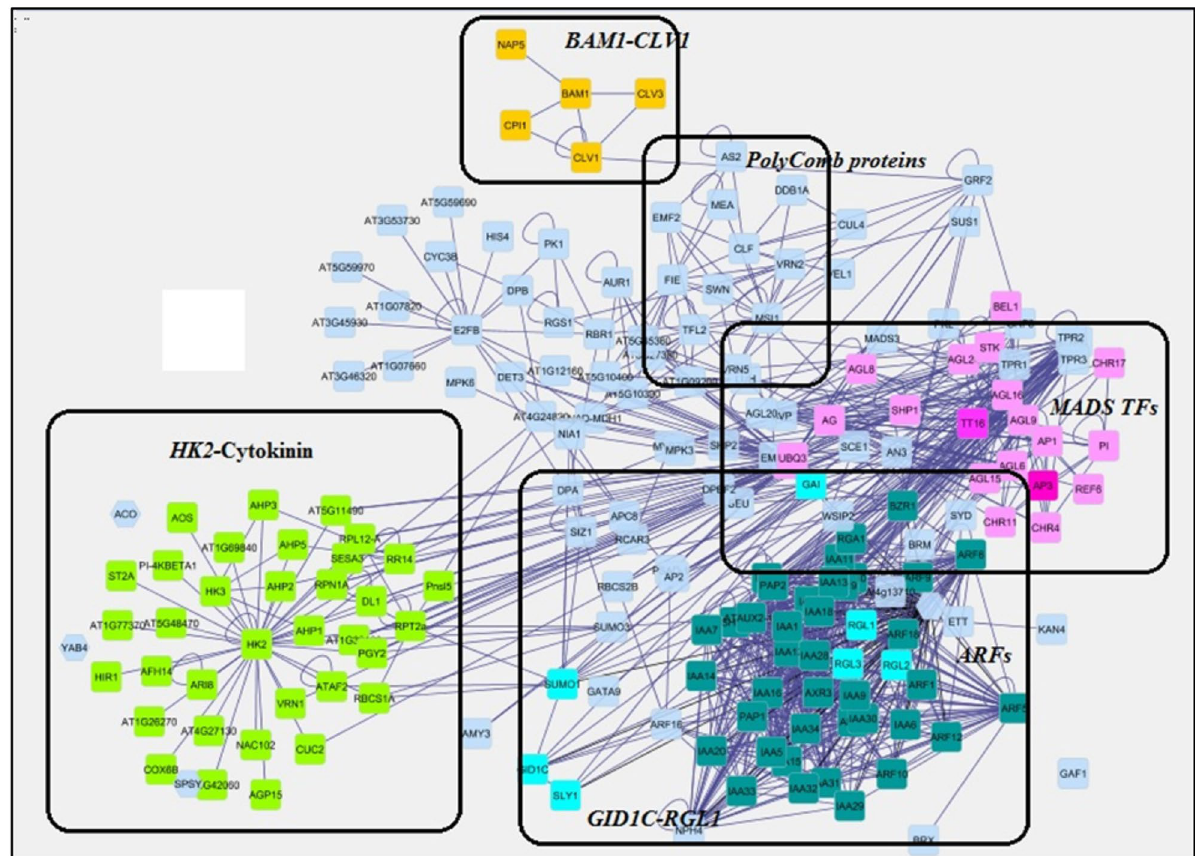
Figure 5. Association of validated candidate genes in the constructed PPI